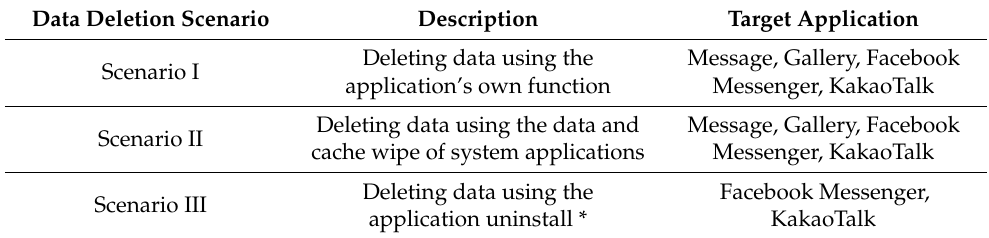
Table 4. Android application data deletion scenarios.